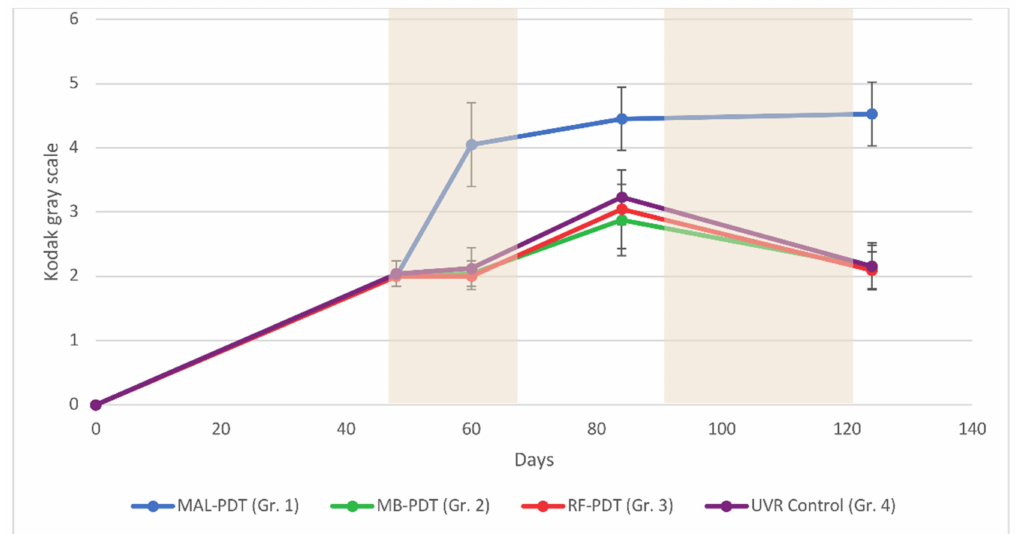
Figure 5. Pigmentation for all groups of mice measured on a Kodak gray scale (arbitrary units, au) and analyzed using one-way analysis of variance (ANOVA). The shaded areas indicate periods with no exposure to ultraviolet irradiation. Abbreviations: MAL, methyl aminolevulinate; MB, methylene blue; RF, riboflavin; Gr.,